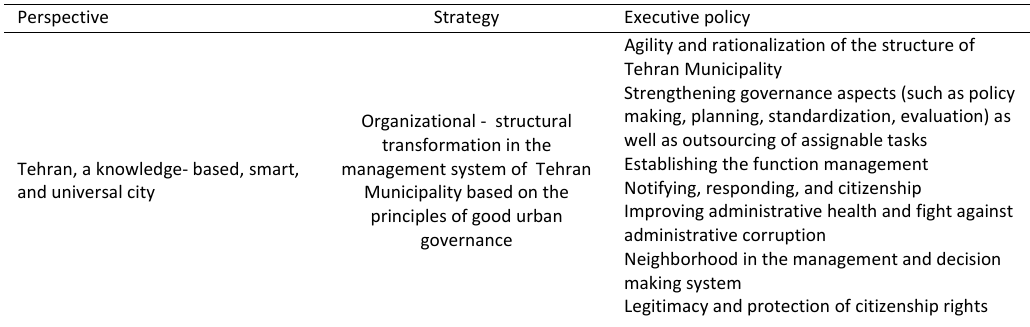
Table 2: Predicted executive policies of Tehran Municipality human resources development Table 2. Predicted executive policies of Tehran Municipality human resources Perspective Strategy